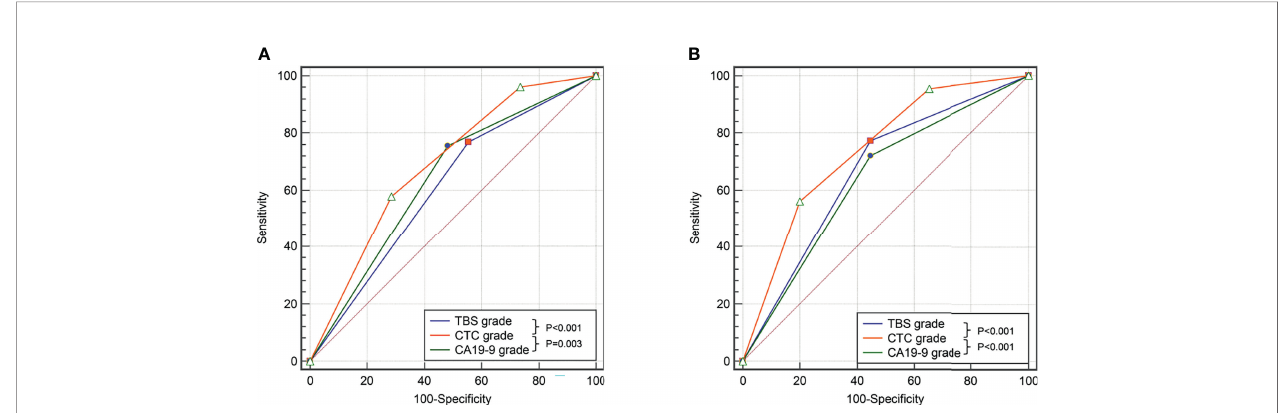
FIGURE 3 | Comparison of the predictive value of TBS, CA19-9, and CTC grade in OS (A) and DFS (B) in the derivation cohort.